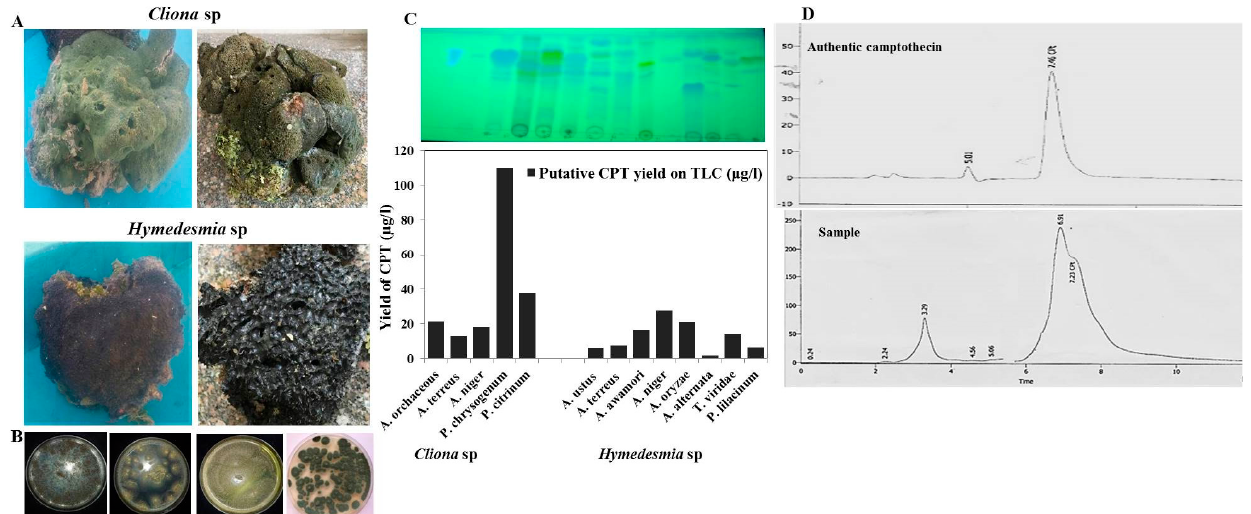
Figure 1. Screening for camptothecin producing fungal endophytes inhabiting marine sponges Cliona sp. and Hymedesmia sp. ( A ), General view of Cliona sp. and Hymedesmia sp. collected from the Red Sea, 20 km away from Sharm El sheikh, Egypt. ( B ), The collected fungal isolates from both sponges were grown on PDB for 10 days at 30 °C, then camptothecin was extracted by methylene chloride, checked by TLC, and visualized by UV at wavelength 254 nm comparing to authentic one. ( C ), TLC chromatogram of methylene chloride extracts from the fungal isolates (Upper panel), and the putative concentration of camptothecin calculated by the Image J software package, normalized to known concentration of authentic camptothecin (Lower panel). ( D ), HPLC chromatogram of extracted camptothecin and authentic one.